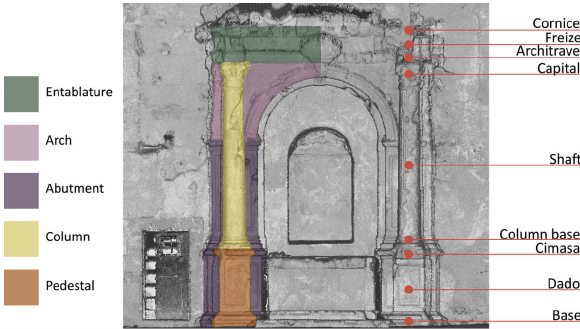
Figure 6.Ontology-driven annotations on the decorative